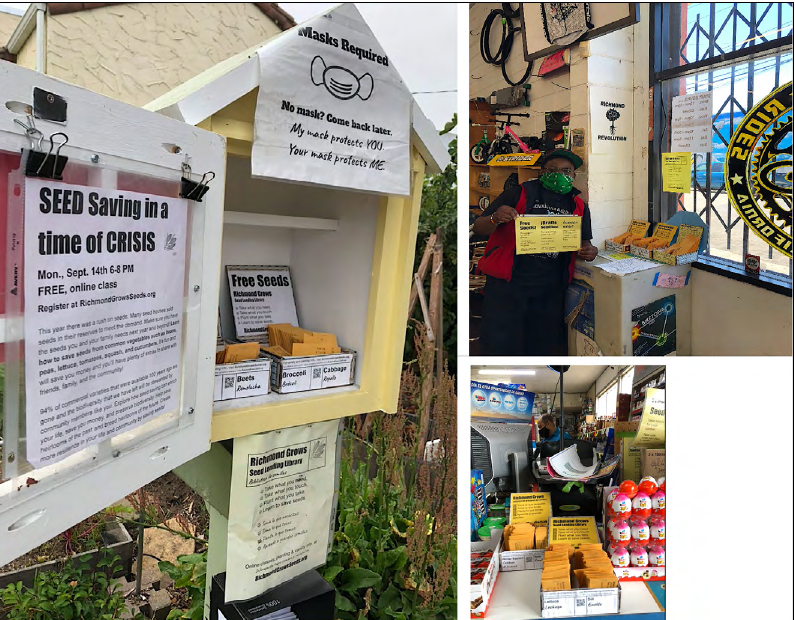
Figure 1 Tiny Free Seed Libraries (TFSLs) established by Richmond Grows Seed Lending Library (RGSLL) in Richmond, CA in response to the COVID-19 crisis,